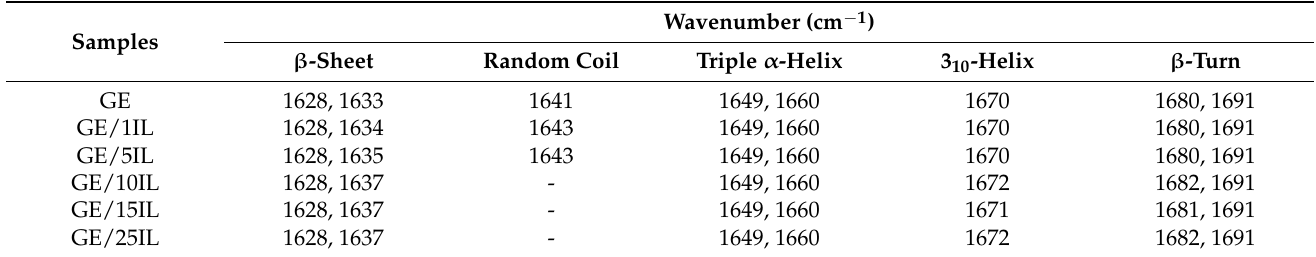
Table 6. Assignments of IR bands to the secondary structure of GE and